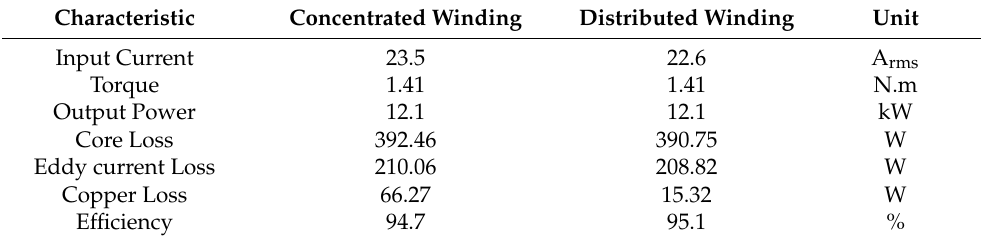
Figure 5. MMF harmonic components of ( a ) concentrated model and ( b ) distributed model. Table 2. High speed motor design specifications according to winding